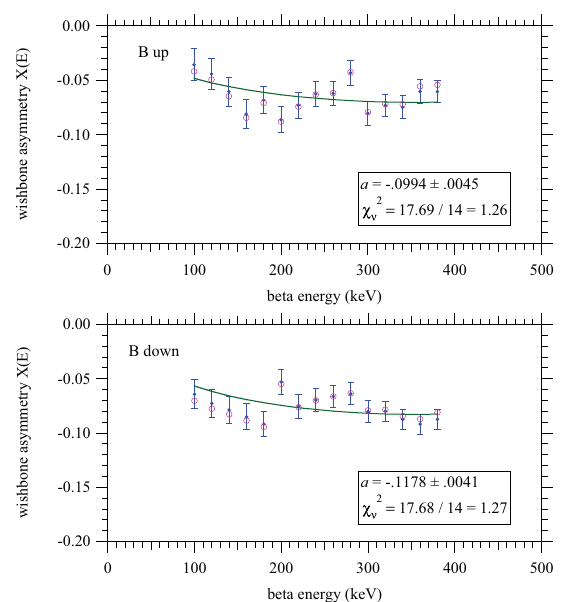
Figure 5. Open circles: The measured, uncorrected, wishbone asymmetry X ( E ) for each magnetic field direction. Solid points: The same data including the corrections δ 1 ( E ), δ 2 ( E ), and the energy-dependent systematic corrections. Error bars are statistical uncertainty. Solid curves: the product af a ( E ), where a is the best fit value of the a coefficient in each case.